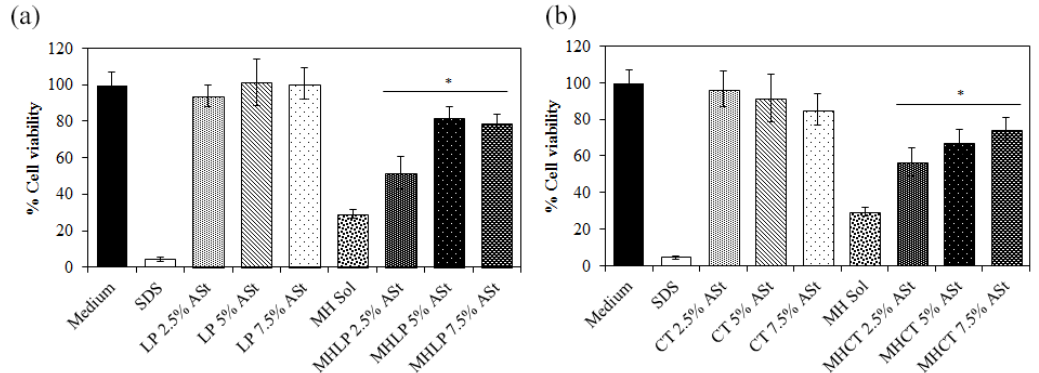
Figure 3. Viability of HaCaT cells after 24 h of incubation with MH at the concentration of 525 µ g/mL, either in the free form or incorporated into the emulsions ( a ) LP ( b ) CT; SDS—sodium dodecyl sulfate (mean ± SD, n = 10) (* p < 0.05).